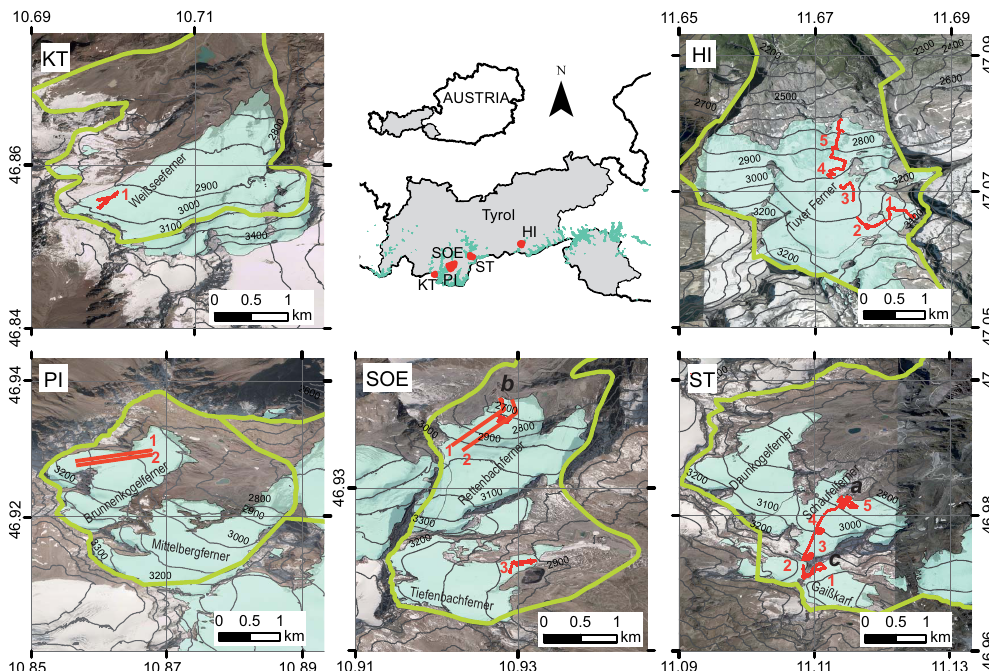
Figure 1. Overview of the Tyrolean glacier ski resorts of Kaunertal (KT), Pitztal (PI), Sölden (SOE), Stubai (ST), and Hintertux (HI). Measurement locations (red lines) with profile numbers (red), ski resort outlines (green lines), glaciers assigned to the resort (light green), and contour lines of the GI3 DEMs superimposed on orthophotos (http://tirol.gv.at). Areas a–c are shown in Fig. 2. Table 1. Glacier ski resorts in Austria with opening year, federal state, glacier names, the total glacier area, the glacier area assigned to the ski resort, and the relative area of the ski resort on glacier with mass balance management (mbm). Ski resort Opening State Glaciers Total glacier Ski resort area on